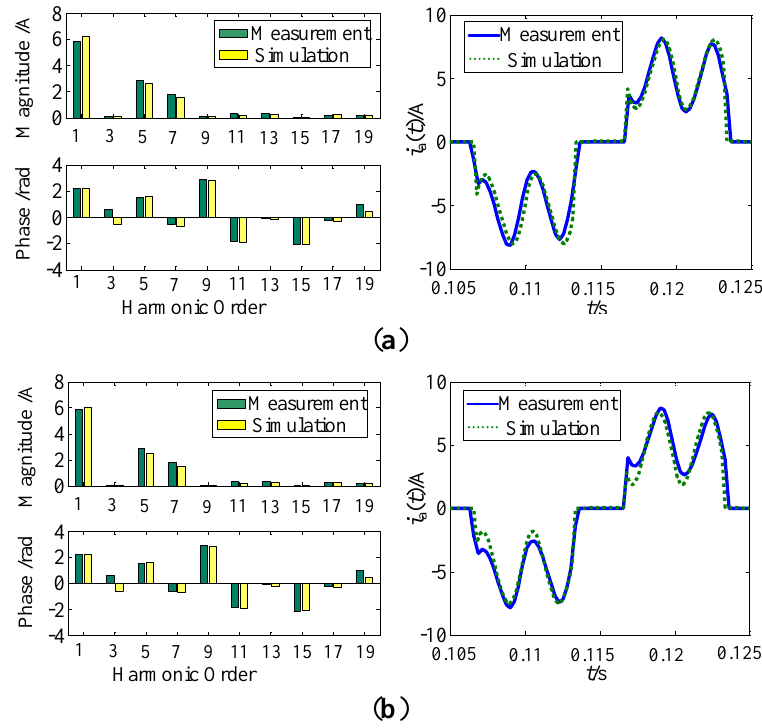
Figure 5. AC current comparison for the charger in continuous current mode: ( a ) case 1 and ( b ) case 2.